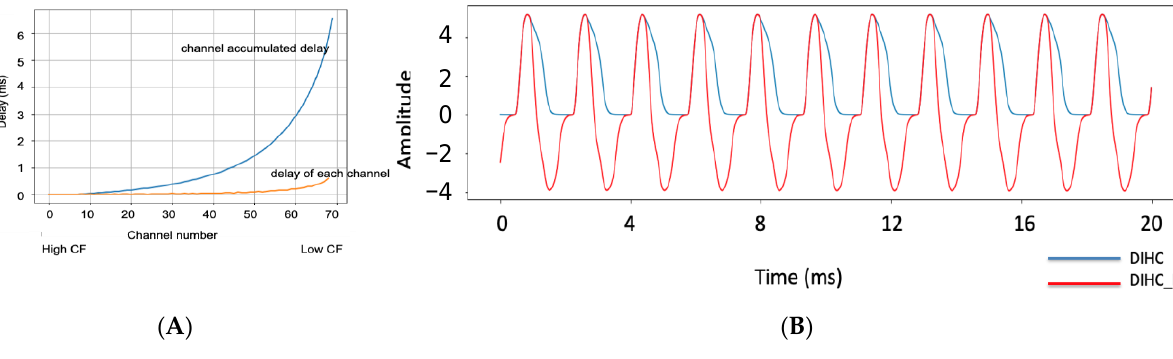
Figure 4. ( A ) Delay of CAR-FAC channels against centre frequency (CF) to a speech and delay of each CAR-FAC channel; ( B ) The CAR-FAC IHC (blue) and the lateral inhibition (red) response to a 500 Hz sine wave on its CF channel (CF corre- sponds to 500 Hz).